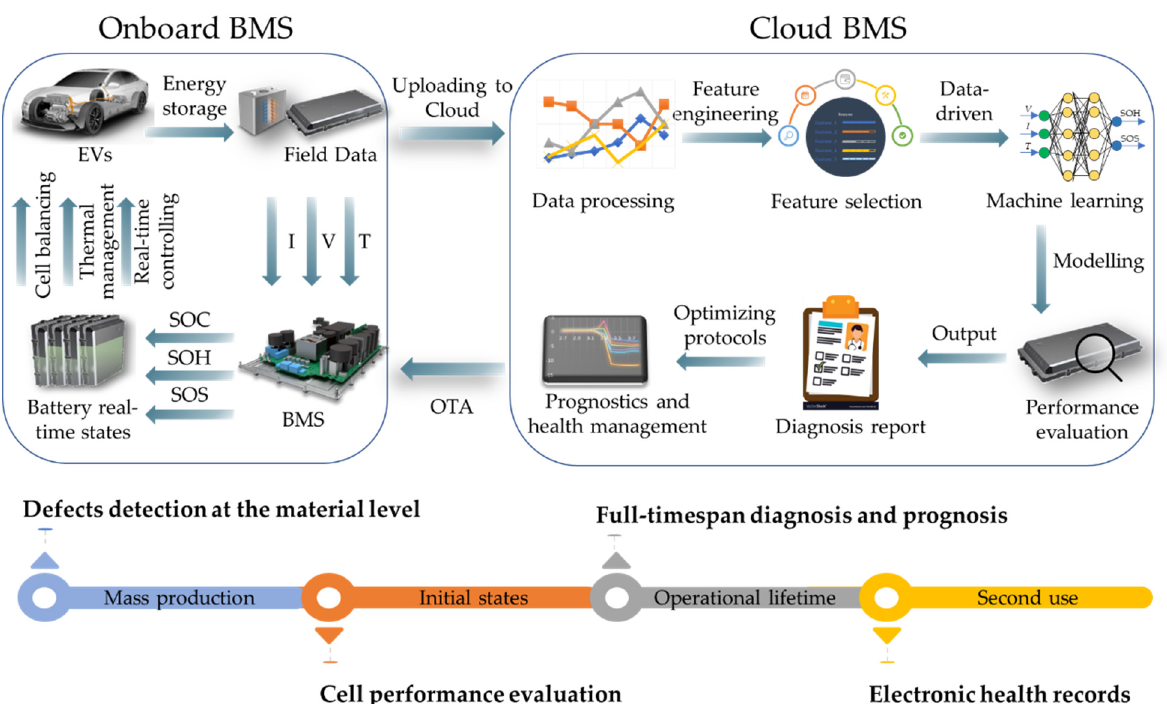
Figure 4. Closed-loop framework for battery prognostics and health management. Onboard BMS provide tools for real-time monitoring and controlling the cells and the pack. It uses the sensor data (voltage, current, and temperature) to estimate the states of the batteries (SOC, SOH, SOS, etc.) based on the pre-trained models. Cell balancing and thermal management provided by BMS is fundamental to the safe operation of the battery system. The field data can be recorded and uploaded to a cloud. Cloud BMS offers opportunities for the learning of the complex battery system using data-driven, machine learning approaches followed by data processing and feature engineering/selection. The data-driven models on the cloud offer a viable path of analyzing and interpreting learning tools for battery performance evaluation and thus generate diagnosis report, which plays key roles in optimizing the protocols used in the prognostics and health management.